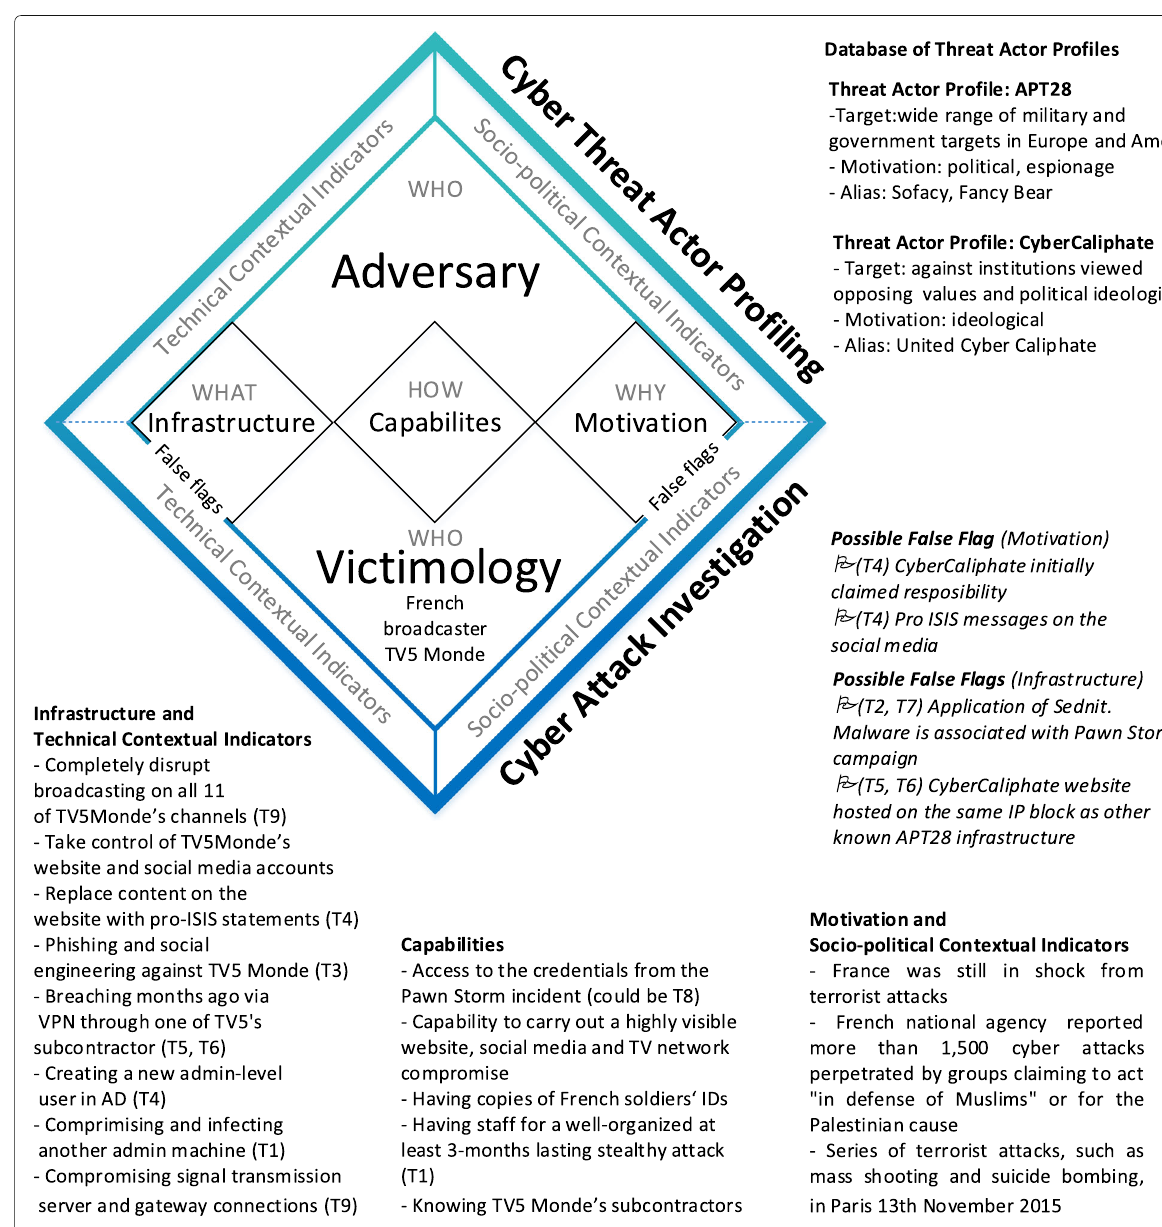
Fig. 6 CAM applied to the TV5Monde APT case